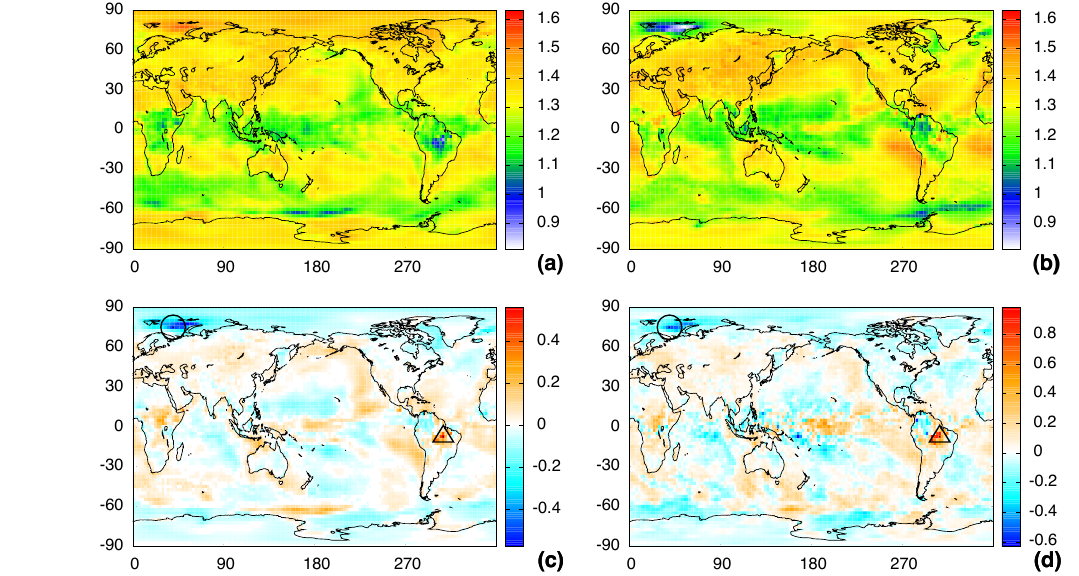
Figure 1. Relative change in the time-averaged Hilbert amplitude. (a) Amplitude averaged over the first 10 years (January 1979 to Decem- ber 1988). (b) Amplitude averaged over the last 10 years (July 2007 to June 2016). (c) Relative change in the Hilbert amplitude, (cid:49)a/ < a > . (d) Relative change in amplitude of the seasonal cycle computed from the amplitude of the climatology, (cid:49)a (clim) /a (clim) . A good qualitative agreement is seen in the spatial structures in (c) and (d) . Importantly, the structures uncovered by the Hilbert amplitude are well defined in comparison with those uncovered by the analysis of the climatology amplitude, which look